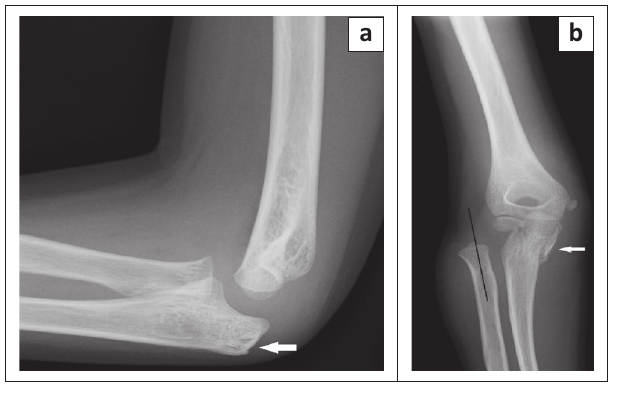
FIGURE 16: (a) Soft tissue swelling overlying the olecranon, which has a subtle undisplaced fracture (arrow). (b) Olecranon fracture (arrow) in the setting of dislocation. Note the interrupted radiocapitellar line (black line).